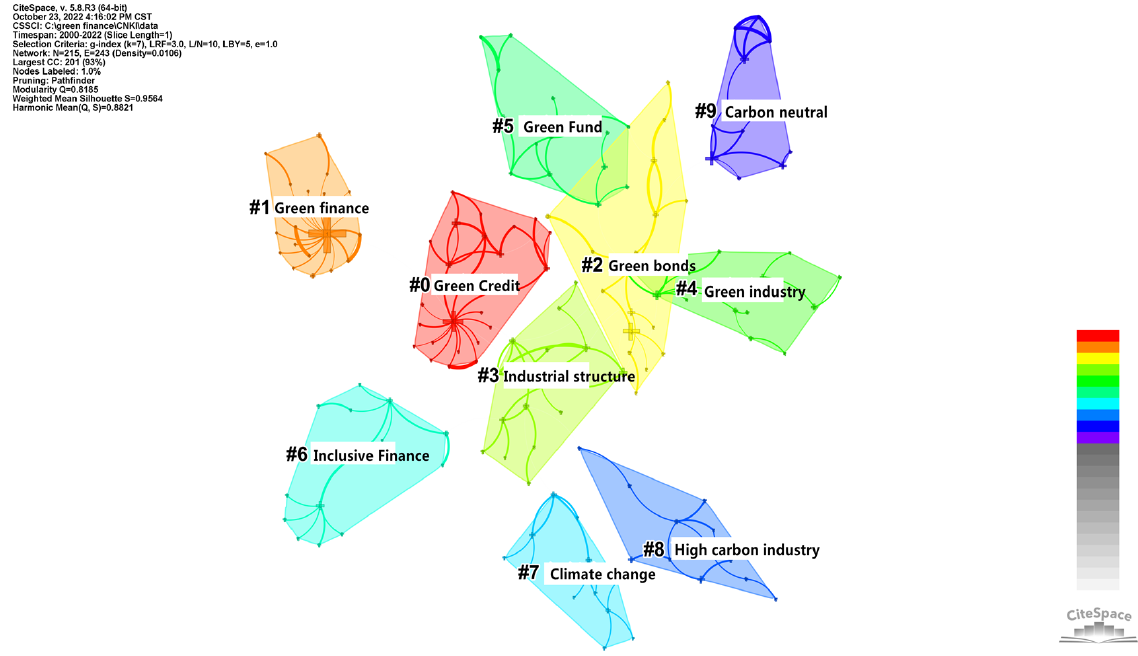
Figure 10. CNKI keyword clustering.